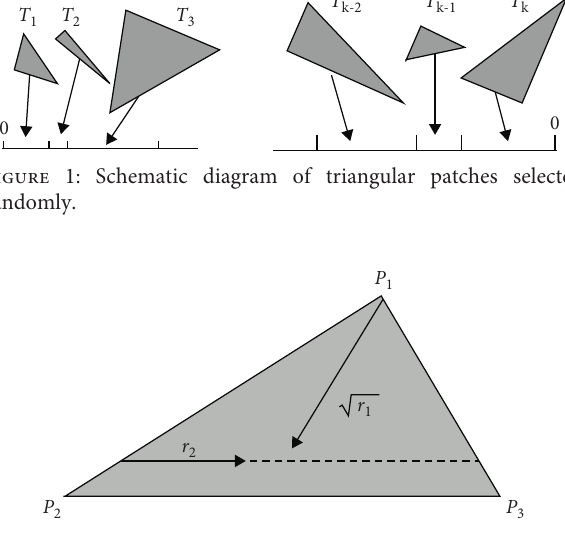
Figure 2: Schematic diagram of randomly generated points on a triangular patch.